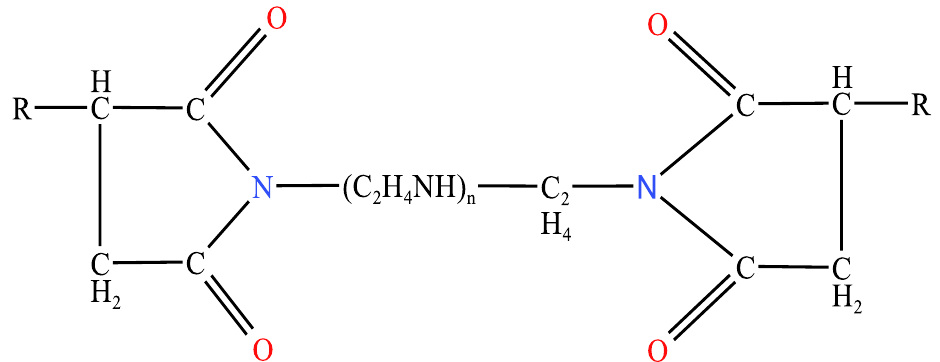
Figure 2. Molecular structural formula of polyisobutene succinimide (T152).